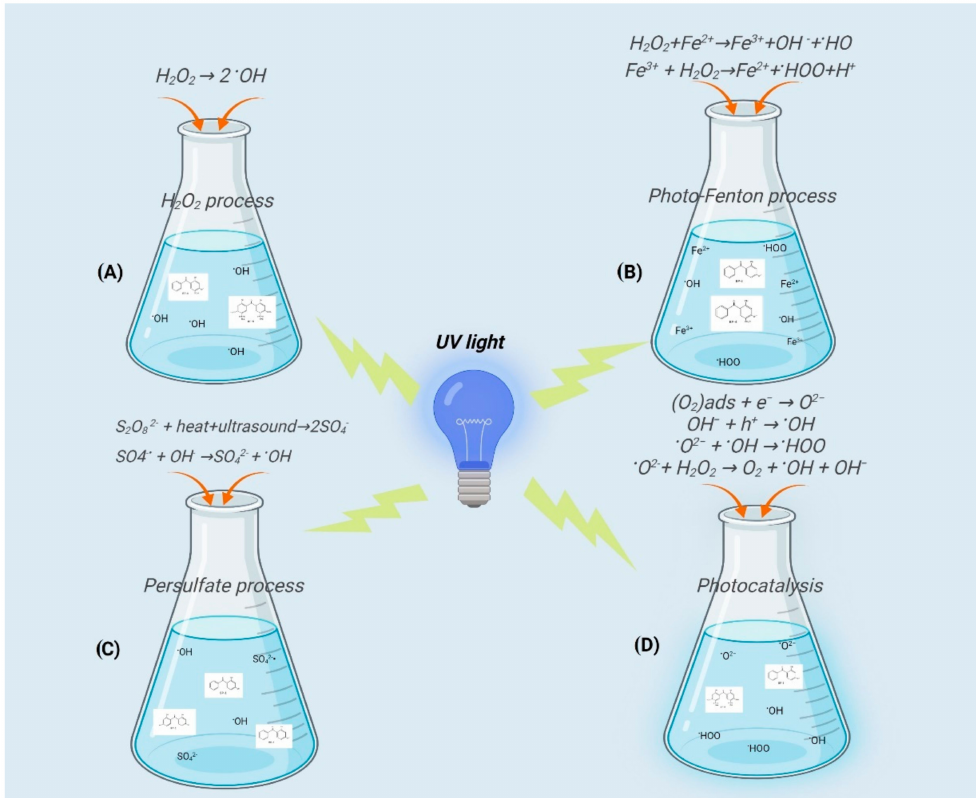
Figure 2. Common advanced oxidation processes for removal of benzophenone-type UV filters from water